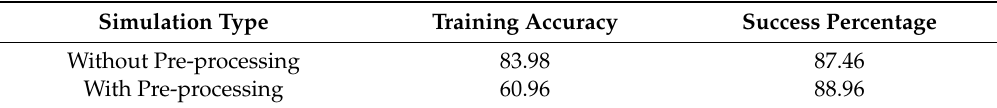
Figure 7. Five RSS fingerprints for 20 APs at RP-1 ( a ) raw database without pre-processing ( b ) database with pre-processing. Table 2. Summary of simulation